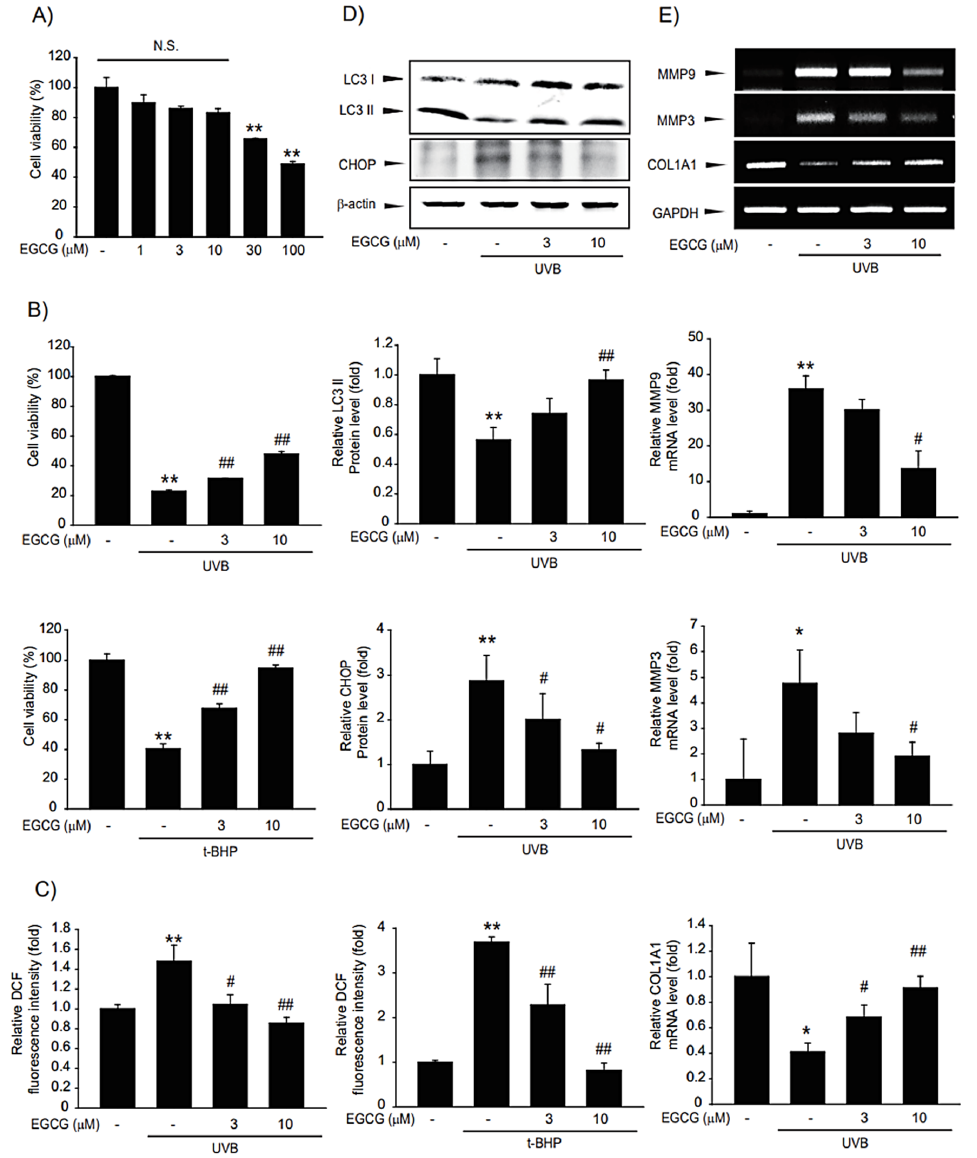
Figure 8. Effects of epigallocatechin (EGCG), the major component of CSL3, on UVB-photodamaged HaCaT cells. ( A ) Cytotoxic effects of EGCG in HaCaT cells were determined by MTT assays. Cells were treated with EGCG (1–100 µ M) for 12 h. Data represent means ± S.E. of 3 replicates; significant when compared with respective controls, ** p < 0.01. N.S., not significant ( B ) The cytoprotective effects of EGCG on photodamaged HaCaT cells were evaluated by MTT assays. We first pre-treated with EGCG (3–10 M) for 1 h in HaCaT cells. Then, the cells were exposed to UVB irradiation (30 mJ/cm 2 ) or t -BHP treatment (600 M), followed by incubation with EGCG for 6 h. Cell viability was measured using MTT assay. Data represent means ± S.E. of three replicates; significant when com- pared with controls, * p < 0.05, ** p < 0.01, compared with the UVB irradiation or t -BHP treatment groups, # p < 0.05, ## p < 0.01. ( C ) Effects of EGCG on intercellular ROS production. We first pre- treated with EGCG (3–10 M) for 1 h in HaCaT cells. Then, the cells were exposed to UVB irradiation (30 mJ/cm 2 ) or t -BHP (600 M) treatment, followed by incubation with EGCG for 1 h. Results were confirmed by repeated 3 experiments. ( D ) HaCaT cells were pretreated with EGCG (3–10 M) for 1 h. Then the cells were irradiated with UVB irradiation (30 mJ/cm 2 ), followed by incubation with